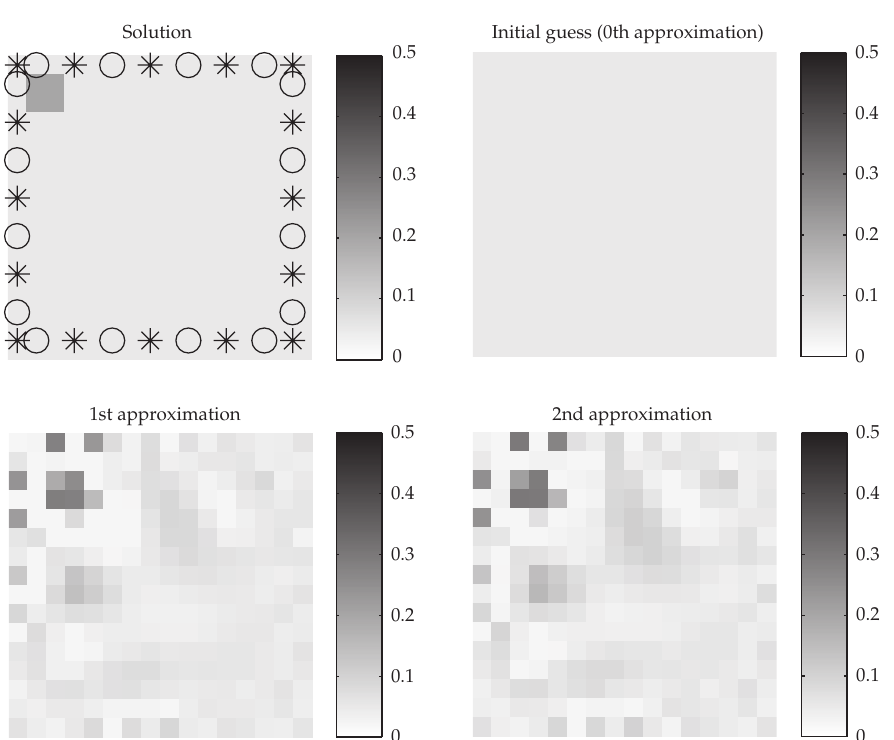
Figure 4: Jindex (cid:10) Nx ∗ Ny ∗ 0 . 4, Jalpha (cid:10) 6 . 5029 e − 009, 10% noise, sources (cid:6) ∗ (cid:8) , and detectors (cid:6) o (cid:8)